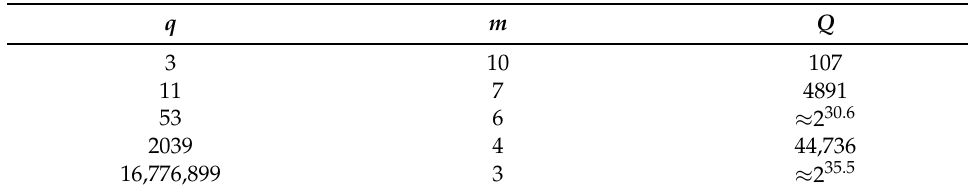
Table 1. Minimal matrix size and maximal number of queries to achieve CPAadv [ A , ε (cid:48) ] < 2 − 112 for distinct values of q . q m Q 3 10 107 11 7 4891 53 6 ≈ 2 30.6 2039 4 44,736 16,776,899 3 ≈ 2